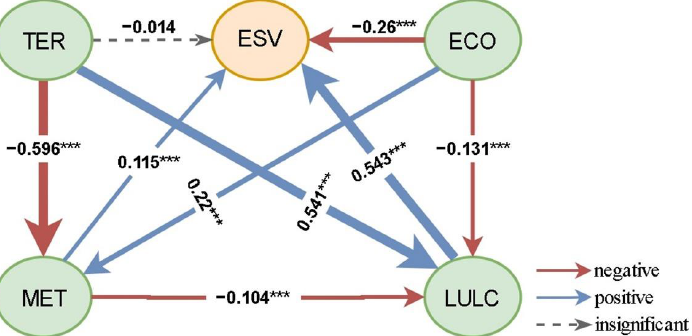
Table 8. Direct and indirect effects in the structural model.